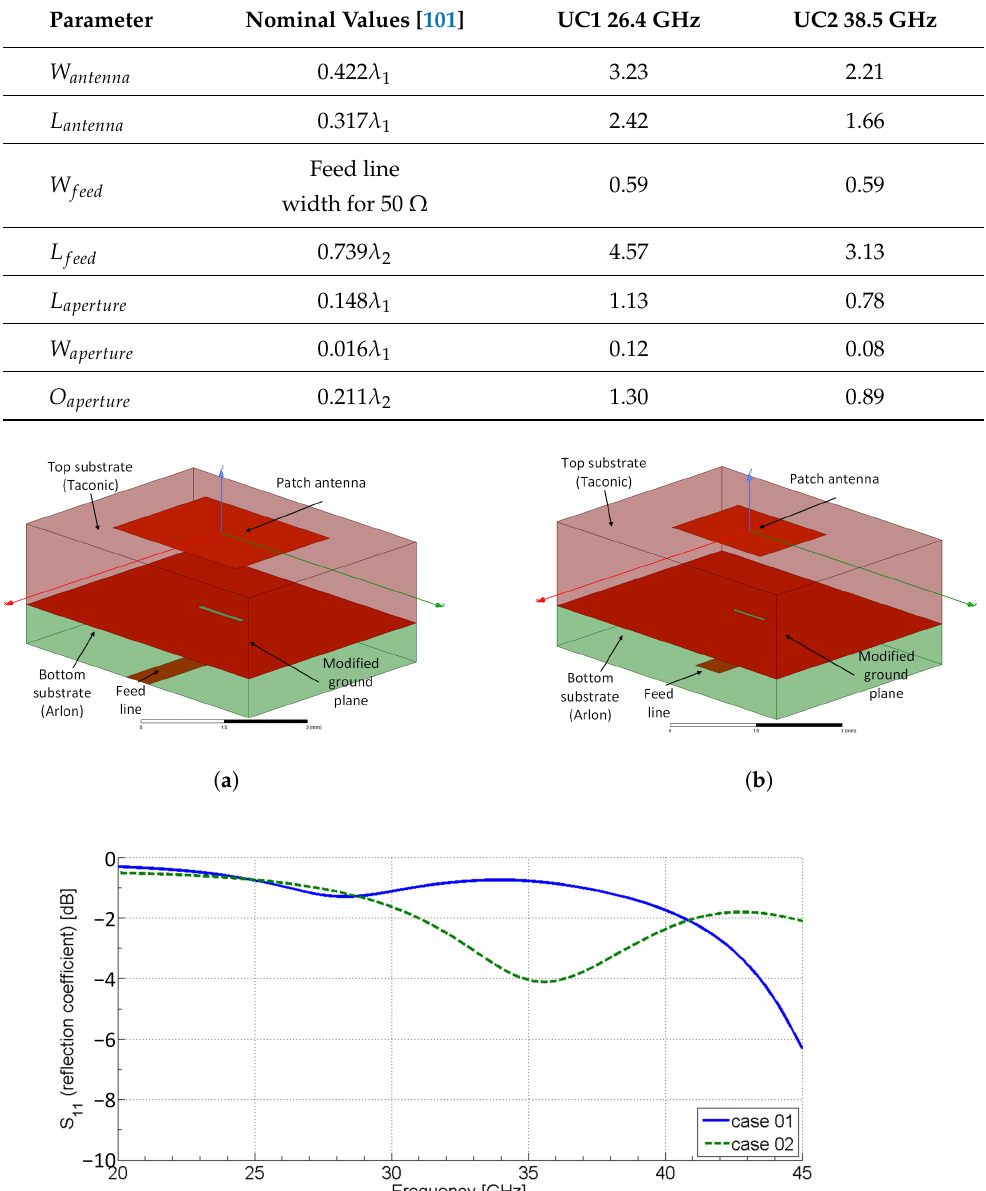
Table 6. Extracted parameter values as they obtained from the design method presented in [101], λ 1 is the wavelength of the antenna dielectric, and λ 2 is the wavelength of the feed dielectric (computed values are expressed in mm).